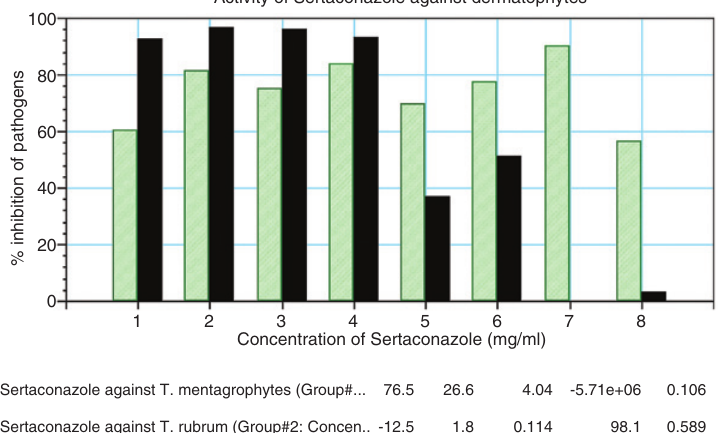
Figure 6: Graphical representation of antifungal susceptibility of dermatophytes against sertaconazole.